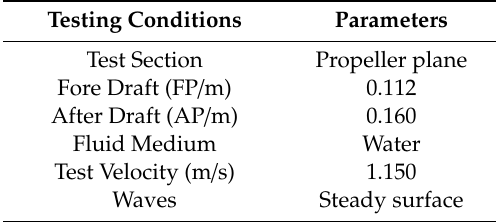
Table 2. PIV test conditions under the ballast